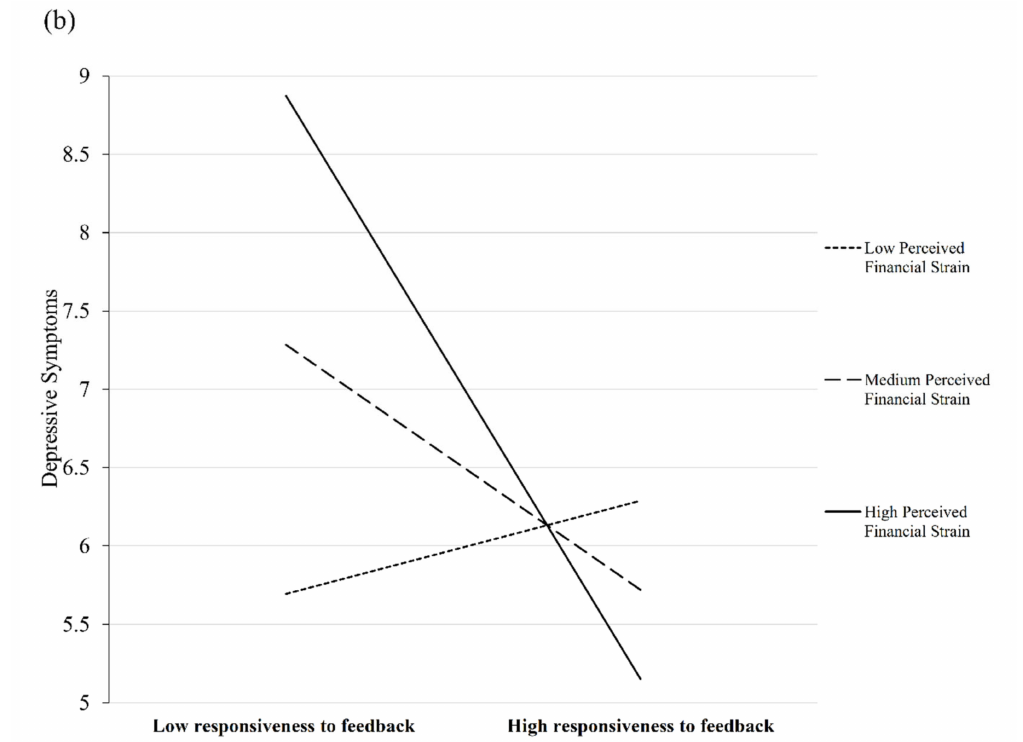
Figure 1. Plot of the moderating effect of perceived financial strain on the association of context sensitivity ( a ) and responsiveness to feedback ( b ) in routines with depressive symptoms.